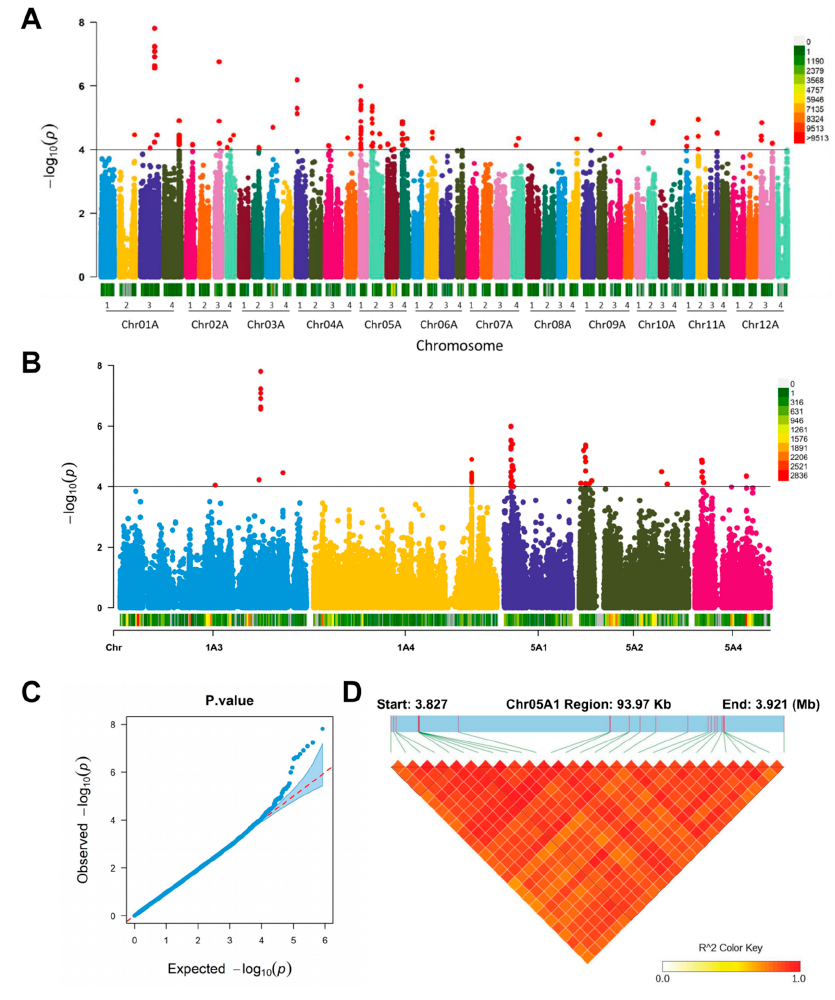
Figure 3. The genome-wide association analysis of plant height. ( A , B ) The Manhattan plot of the plant height. Horizontal axis displays the chromosome: 0–9513 legend insert indicates the SNP density ( A ) and 0–2836 legend insert indicates the SNP density ( B ); ( C ) Quantile–quantile plot for the plant height; ( D ) the LD heat map of the plant height associated region on Chr05A1; Red and white color legend insert indicate high and low degree of linkage disequilibrium, respectively.